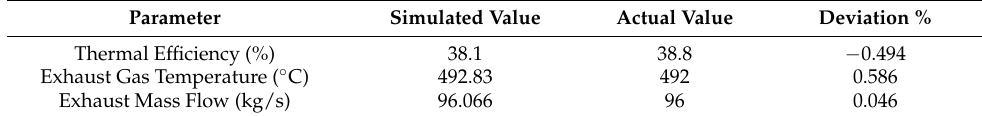
Table 1. Turbomatch output design point (D.P.) parameters of the simple-cycle gas turbine.